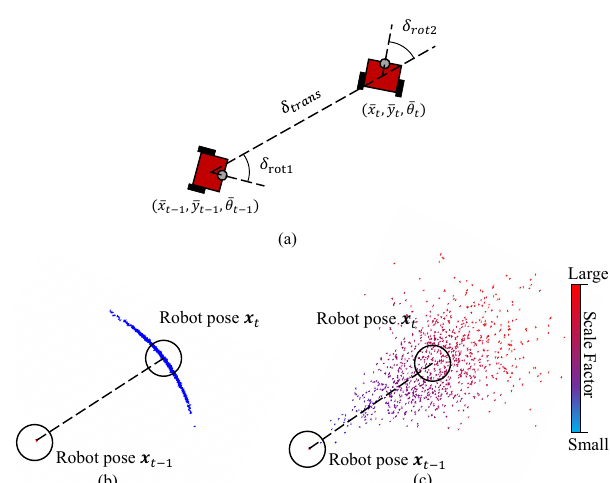
Figure 3. ( a ) motion model of the robot, ( b ) sampling 1000 particles from the classical motion model, ( c ) sampling 1000 particles from the motion model with scale uncertainty. The colors of the points are used to represent the specified scale factors. The darker color represents smaller scale factor s t